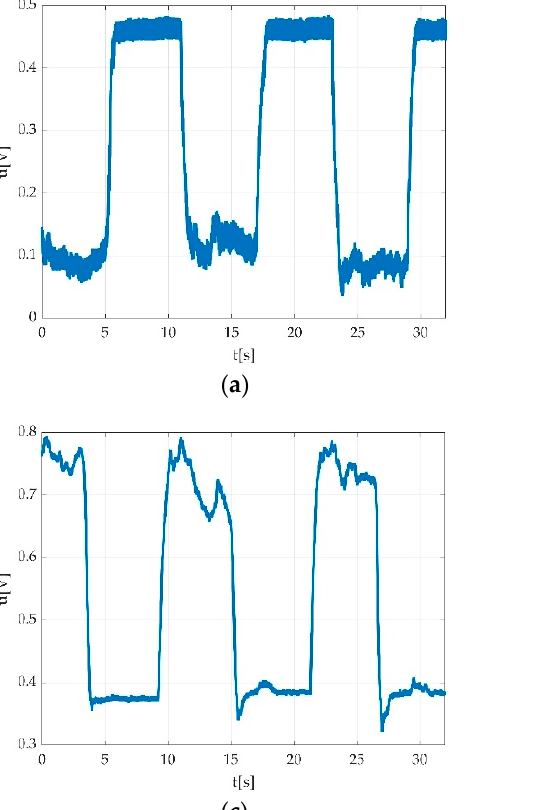
18 of 30 Figure 17. Example of measurement with non-uniform time interval during MVIC, the longer con- traction time (third MVIC).